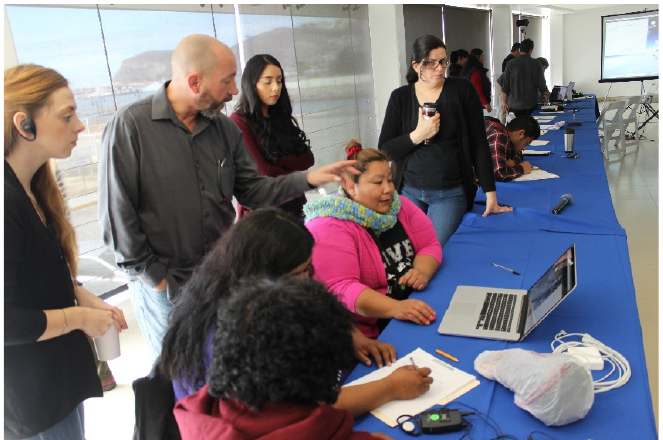
Figure 3. Nunaliit workshop in the city of Ensenada. Pa Ipai families during learning how to use the Nunaliit software. Credits: Martín Cuitzeo Domínguez Núñez.